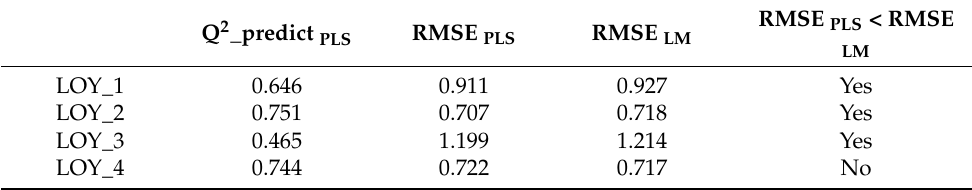
Table 4. Structural model predictive power assessment. Q 2 _predict